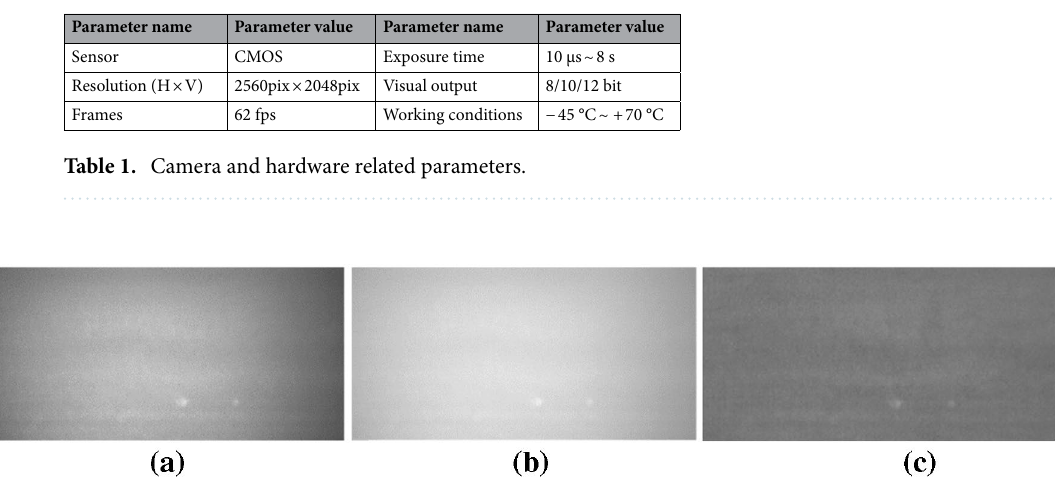
Figure 1. Data acquisition equipment to collect original images of surface defects on particleboard: ( a ) system hardware composition, ( b ) schematic diagram of image acquisition process.